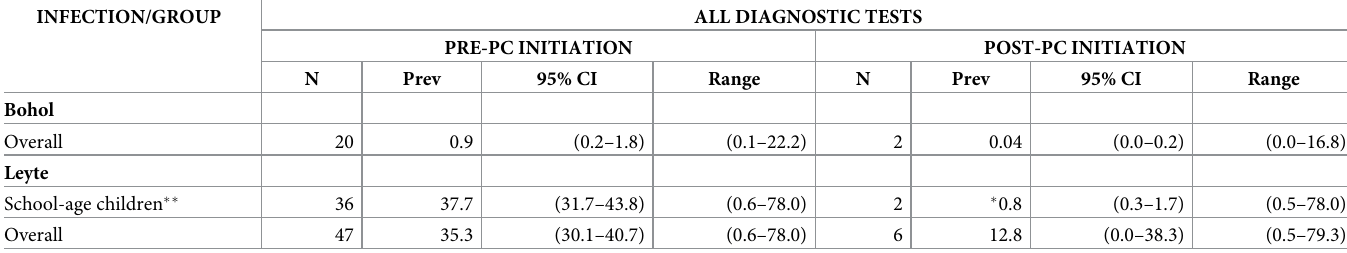
Table 6. Meta-analyses of prevalence of S . japonicum by preventive chemotherapy status and population group in Bohol and Leyte provinces